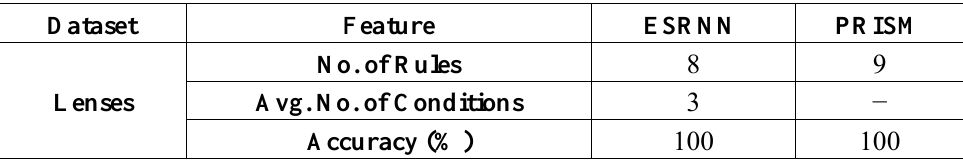
Table 15. Performance comparison of ESRNN with other algorithm for lenses